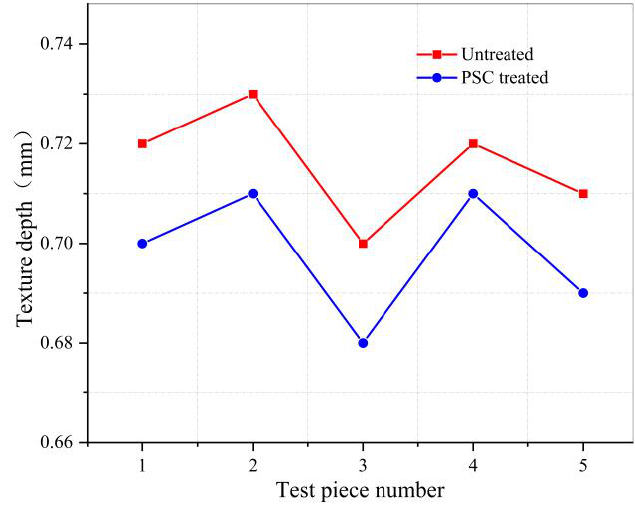
Table 5. Texture depth test results.